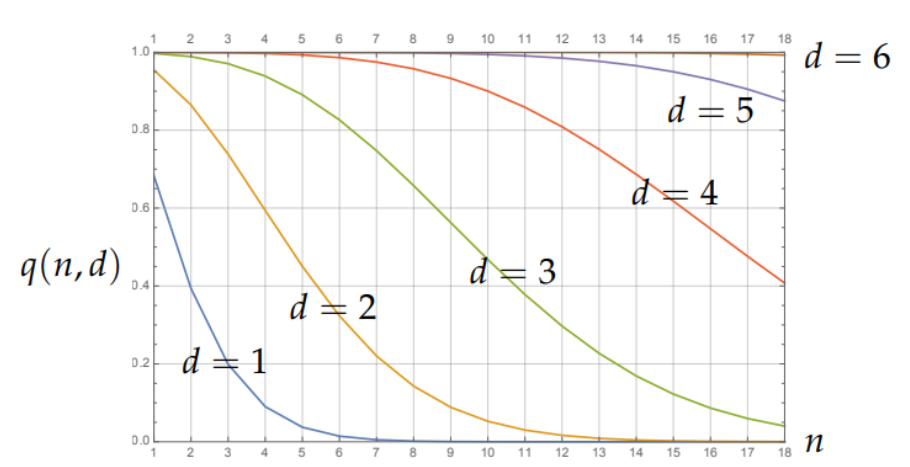
Figure A2. Profiles of the accumulated Gaussian probability mass q ( n , d ) of Equation (A5) for several values of space dimensionality n and Mahalanobis distance d